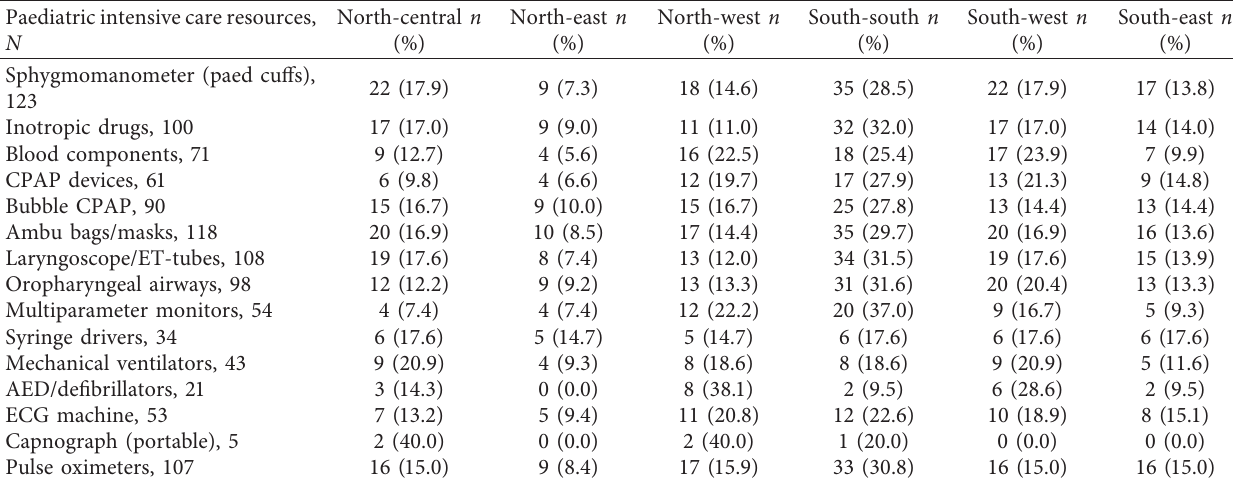
Table 4: Distribution of paediatric intensive care resources in various zones of Nigeria ∗ .